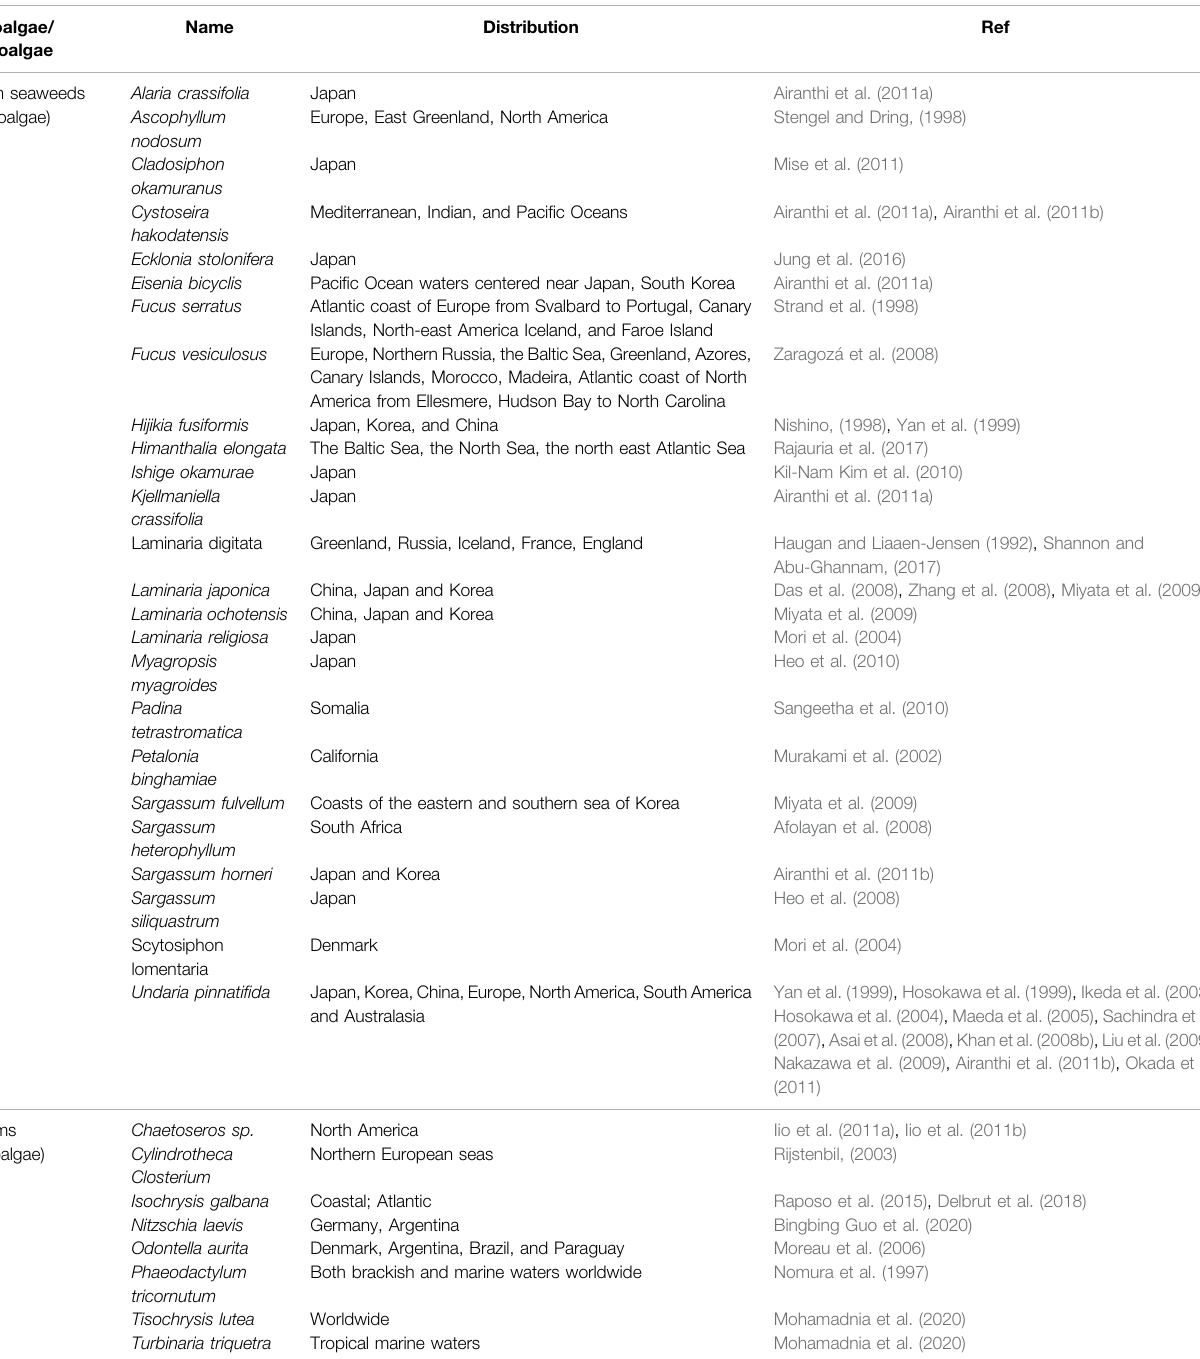
TABLE 1 | Sources of FX and their